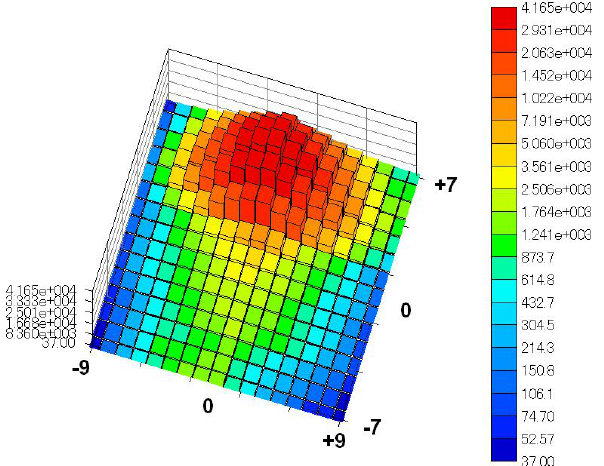
Fig. 2. Muon events collected in the present experiment as a func- tion of azimuth and elevation angle. The horizontal and vertical bin width is 100 × 100mrad, larger than the experimental angular reso- lution, which was estimated to be ± 40mrad (root mean square).